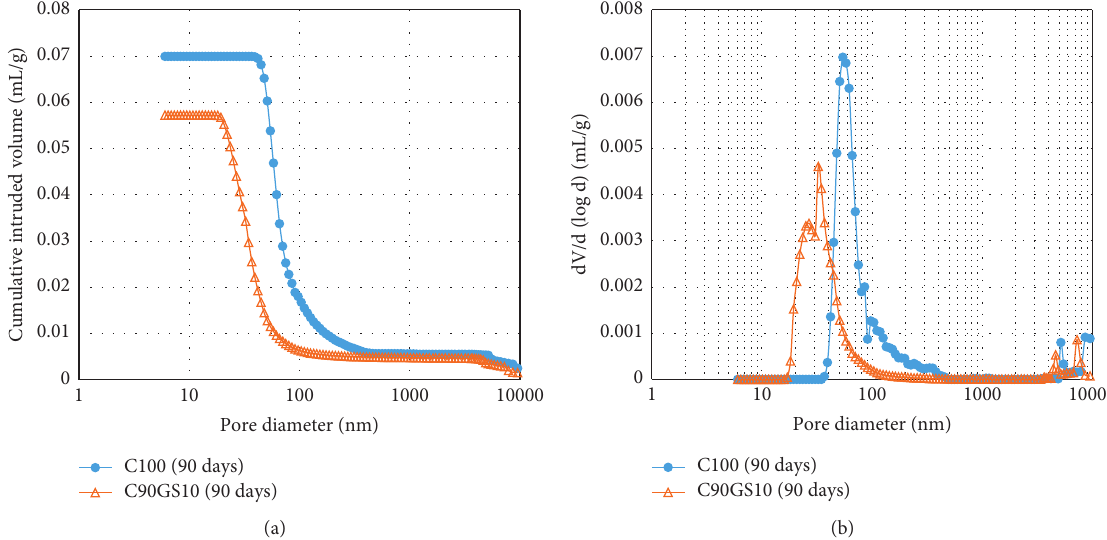
Figure 5: Porosity of specimens with a W/B of 0.25 at 90 days. (a) Cumulative intrusion curve showing the cumulative pore size distribution. (b) Differential pore size distribution, identifying the most probable pore